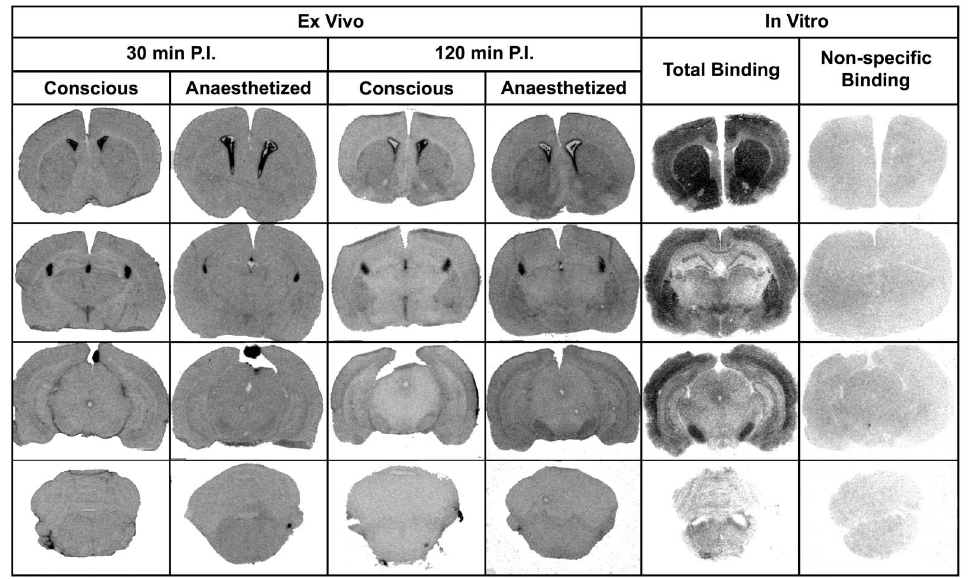
Fig. 6. The regional distribution of [ 125 I]WYE-230949 uptake in rat brain sections. Ex vivo autoradiograms show the distribution and regional levels of radioactivity in the tissue at 30 or 120 min after administration of [ 125 I]WYE-230949. In vitro autoradiograms show total and non-specific binding following incubation with 5 nM [ 125 I]WYE-230949 or 5 nM [ 125 I]WYE-230949 + 5 m M iodophenpropit respectively. Note the relatively low level of binding in the cerebellum, the reference region used to calculate region of interest specific binding ratios presented in Table 1 with higher binding in the substantia nigra, nucleus accumbens, choroid plexus and pineal